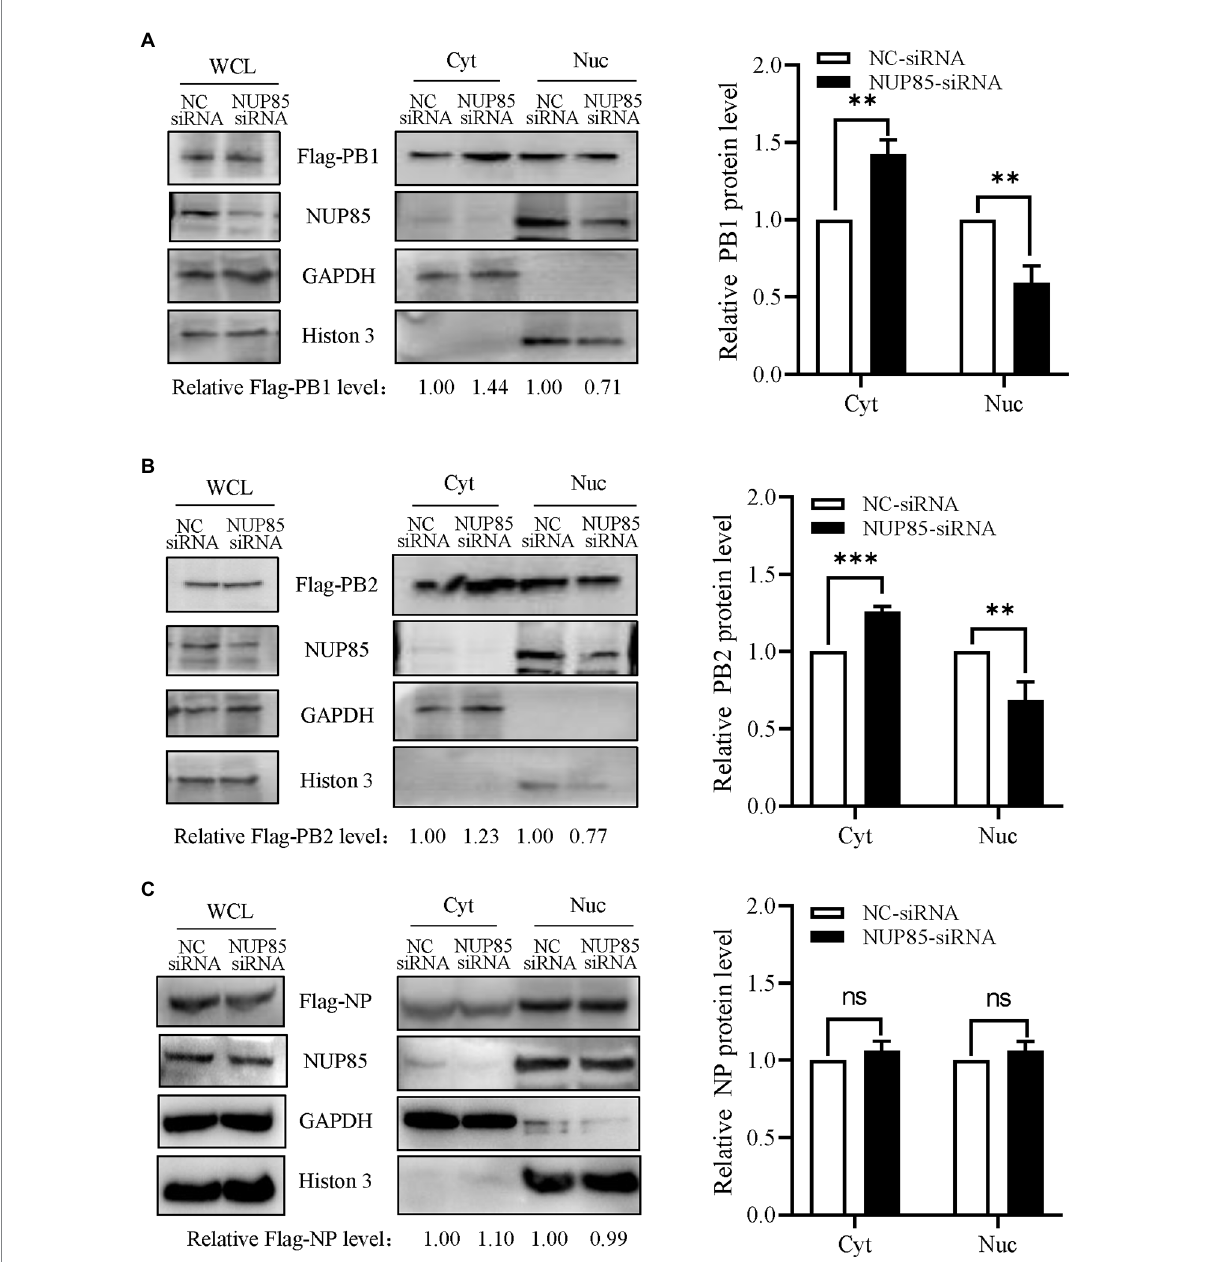
FIGURE 5 Knockdown of NUP85 affects the nucleocytoplasmic distribution of viral PB1 and PB2, but not NP. (A) Plasmids expressing Flag-PB1 and PA were transfected into HEK293T cells treated with NUP85 siRNA or NC siRNA, and the nucleocytoplasmic distribution of Flag-PB1 was examined by Western blot and densitometry analysis. Statistical analysis of PB1 distribution in the NC siRNA-treated or NUP85 siRNA-treated cells was shown on the right. (B,C) Plasmids expressing Flag-PB2 (B) or Flag-NP (C) were transfected into HEK293T cells treated with NUP85 siRNA or NC siRNA, and the nucleocytoplasmic distribution of Flag-PB2 was examined by Western blot and grayscale analysis. The statistical analysis of relative band intensity of PB2 (B) or NP (C) was shown on the right. Western blot densitometry analysis was performed using software ImageJ. Histone 3 and GAPDH were used as loading controls for nuclear and cytoplasmic fractions, respectively. The relative protein level of PB1, PB2, and NP in nucleus is indicated with its gray intensity divided by that of Histone 3, and the relative protein level of PB1, PB2, and NP in cytoplasmic is indicated with its gray intensity divided by GAPDH. Then they are normalized by that of control group, the results of which are shown at the bottom panels (A–C) . Data are mean ± SD of three independent experiments. Significance is measured by unpaired T -test; ** indicates p < 0.01. *** indicates p < 0.001. ns, no